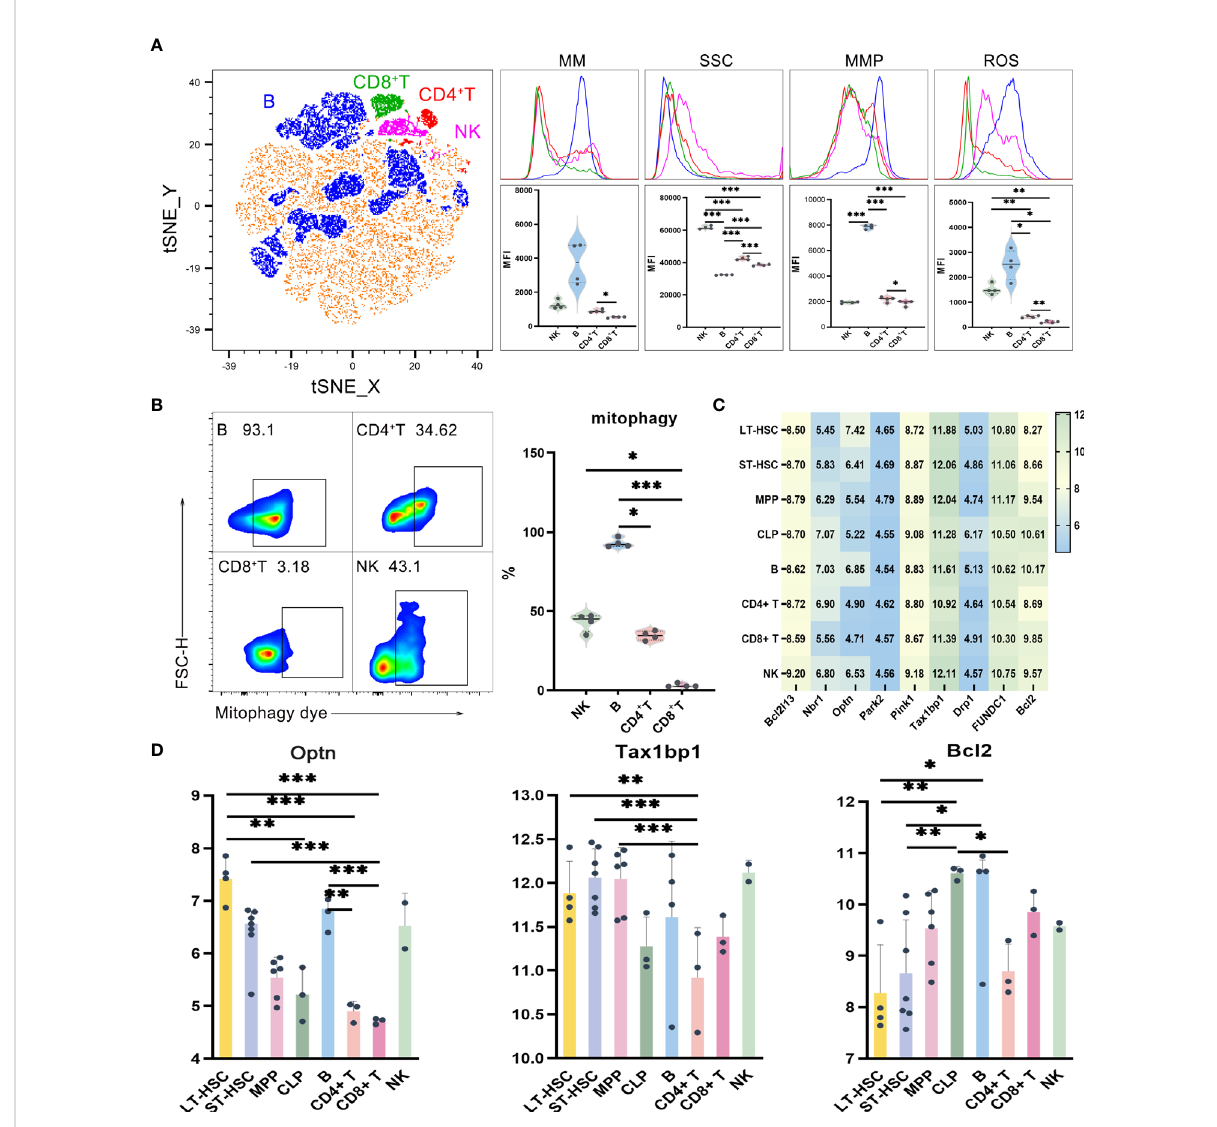
FIGURE 2 (A) t-SNE, MM, SSC, MMP and ROS levels in B, CD4 + T, CD8 + T and NK cells (B) Mitophagy in B, CD4 + T, CD8 + T and NK cells (C) Heat map for the expression level of autophagy-related genes in different types of hematopoietic cells during lymphoid differentiation (D) Statistics for the expression level of autophagy-related genes. Normally-distributed data are presented as the mean ± SD, while non-normally-distributed ones are presented as the median with the interquartile range. One-way ANOVA or the Kruskal – Wallis test was used for comparisons and determining the P values. * P <0.05, ** P <0.01, *** P